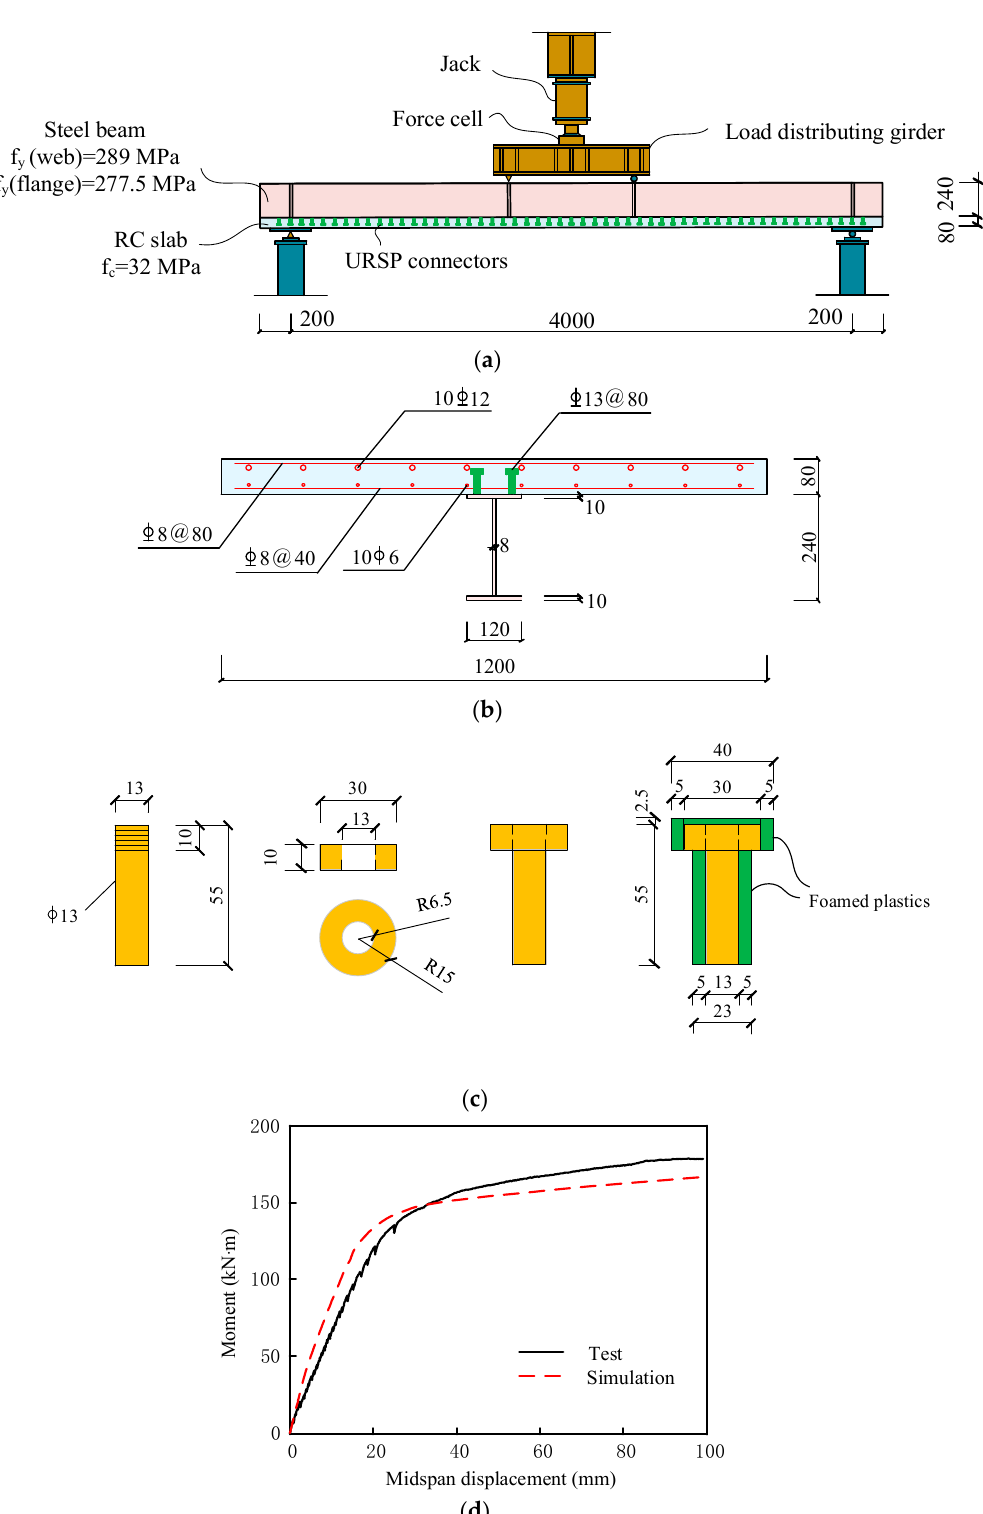
Figure 8. Verification of the proposed model by reference [45]. ( a ) Loading scheme of the beam test (unit: mm); ( b ) cross-section of the beam specimen (unit: mm); ( c ) URSP connectors in the test (unit: mm); ( d ) comparison of test and simulation results.